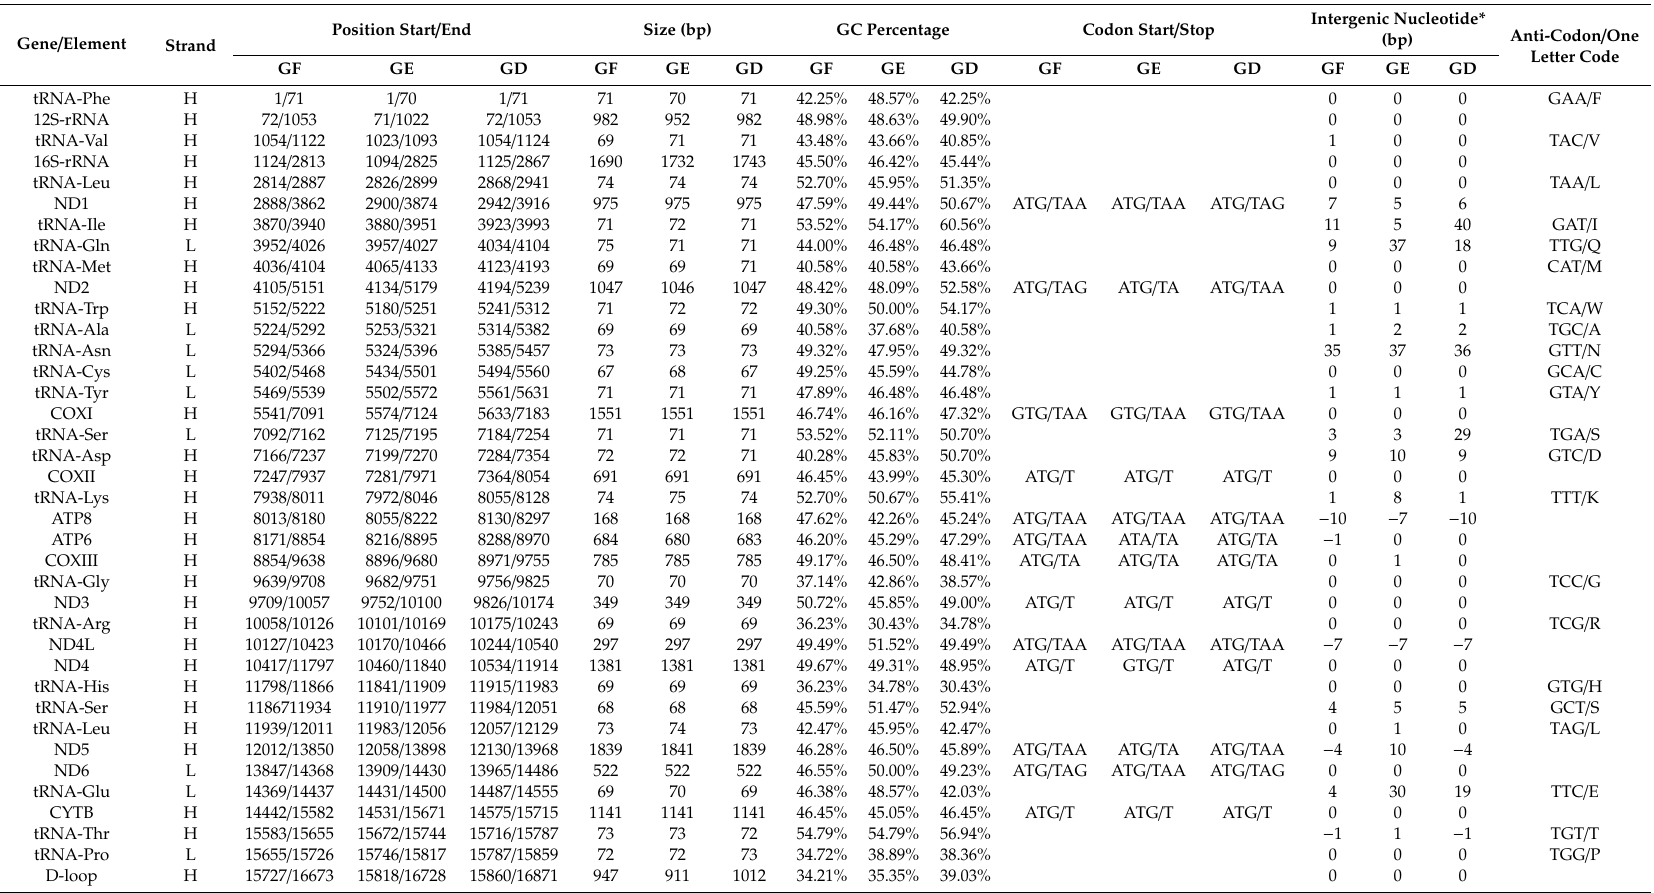
Table 1. Summary of gene / element feature of G. filamentosus (GF), G. erythrourus (GE), and G. decacanthus